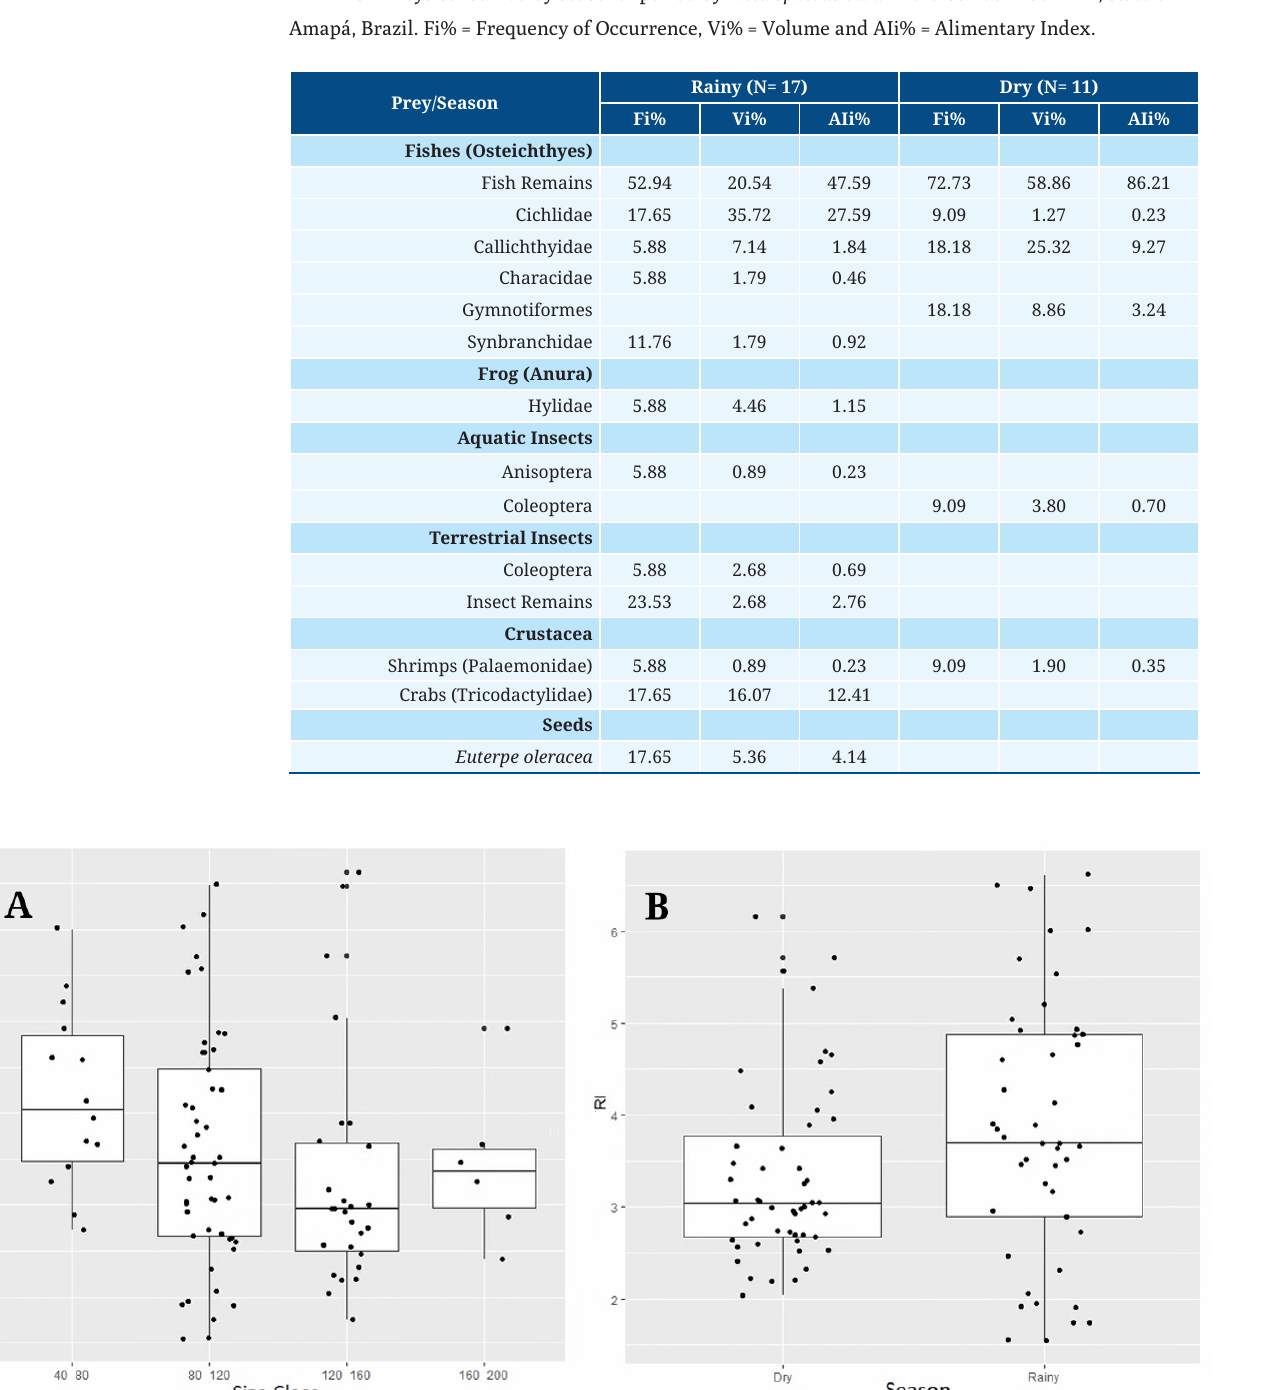
TABLE 3 | Preys consumed by seasonal period by Electrophorus varii in the Curiaú River EPA, state of Amapá, Brazil. Fi% = Frequency of Occurrence, Vi% = Volume and AIi% = Alimentary Index.